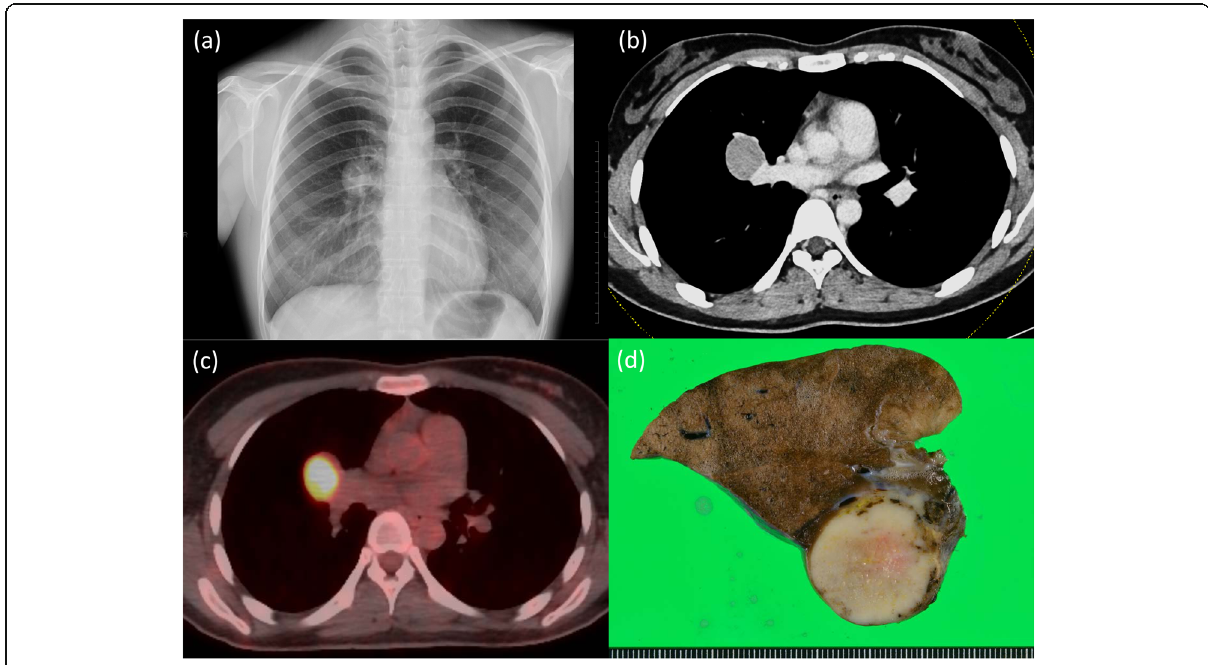
Fig. 1 Radiological findings and macroscopic appearance of the tumor. a Chest X-ray revealed a shadow in the right middle lung field. b Computed tomography revealed a tumor in the right upper lobe. c F-18 fluorodeoxyglucose positron emission tomography revealed high accumulation of FDG in the lesion of the right upper lobe. d Macroscopic appearance of the tumor, which appeared as a solitary, white-colored, well-defined, and solid